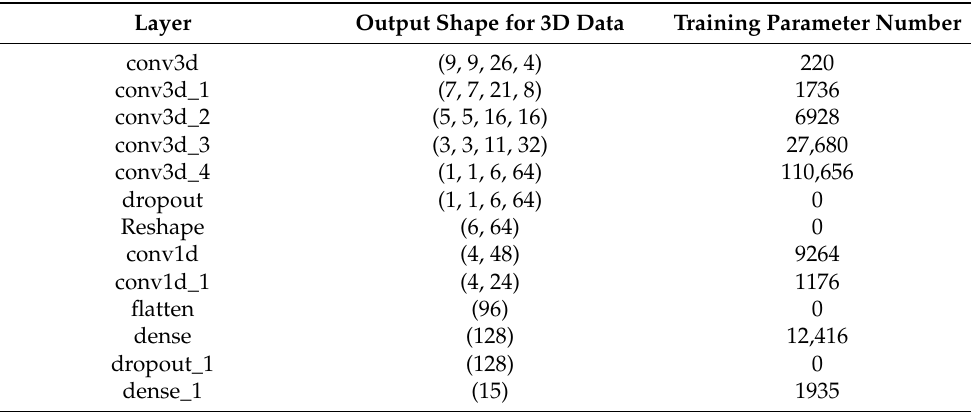
Table 5. 3D-1D-CNN model